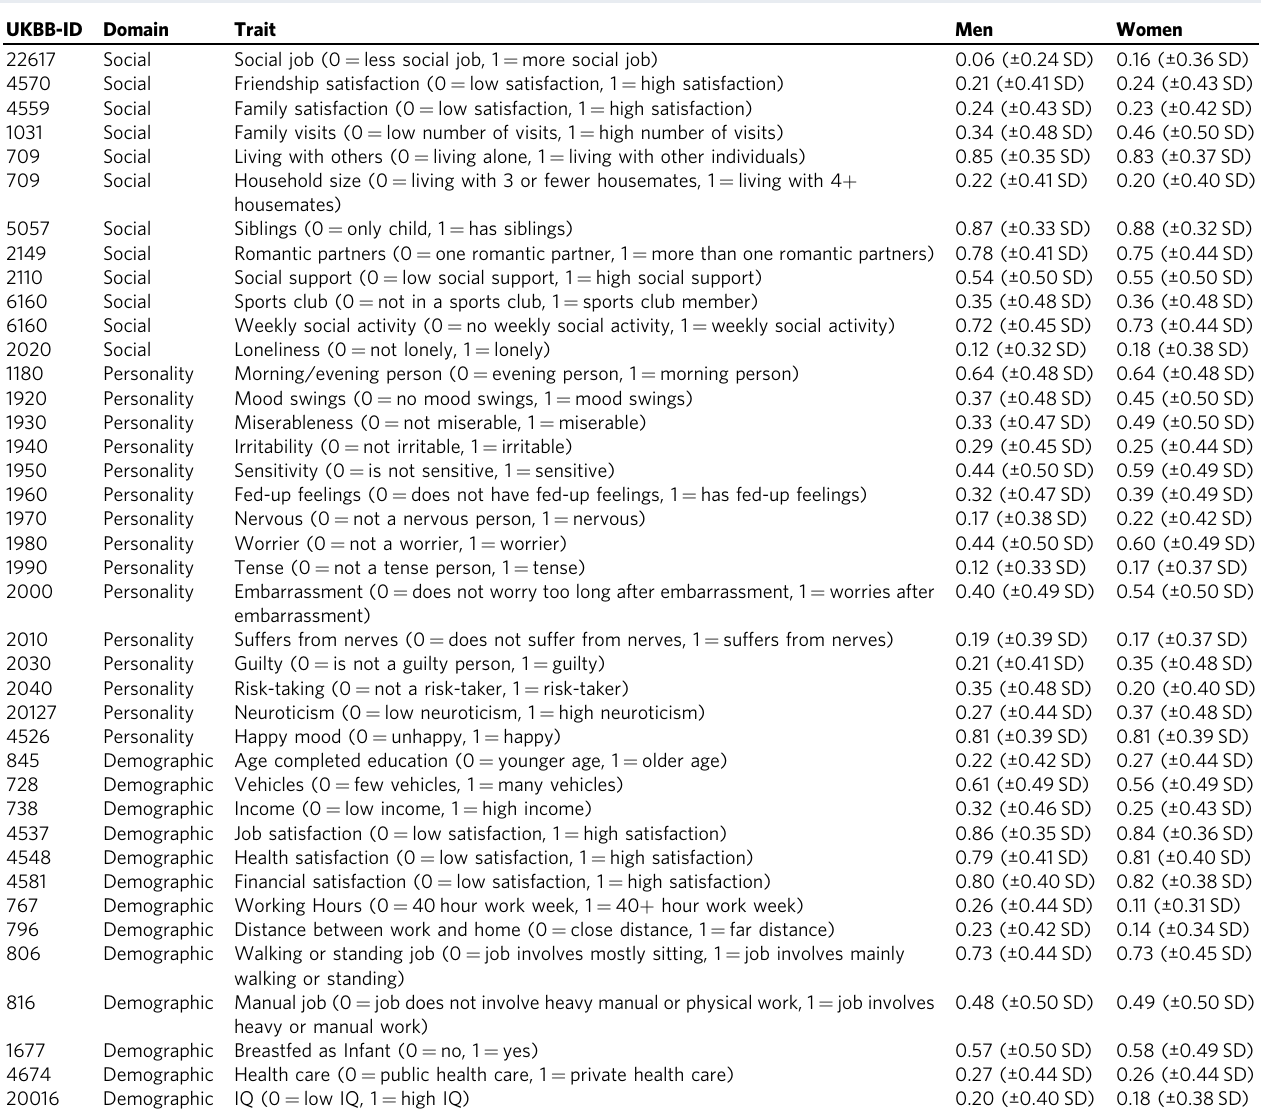
Table 2 List of the 40 examined traits available in the UK Biobank. Each lifestyle indicator of interest from UK Biobank participants is shown alongside its fi eld identi fi cation number. Each indicator was analyzed in two groups according to sex. All indicators were divided into one of three categories, de fi ned by traits related to regular social interaction (social domain), traits related to personality (personality domain), and traits related to demographic standing and environment (demographic domain).